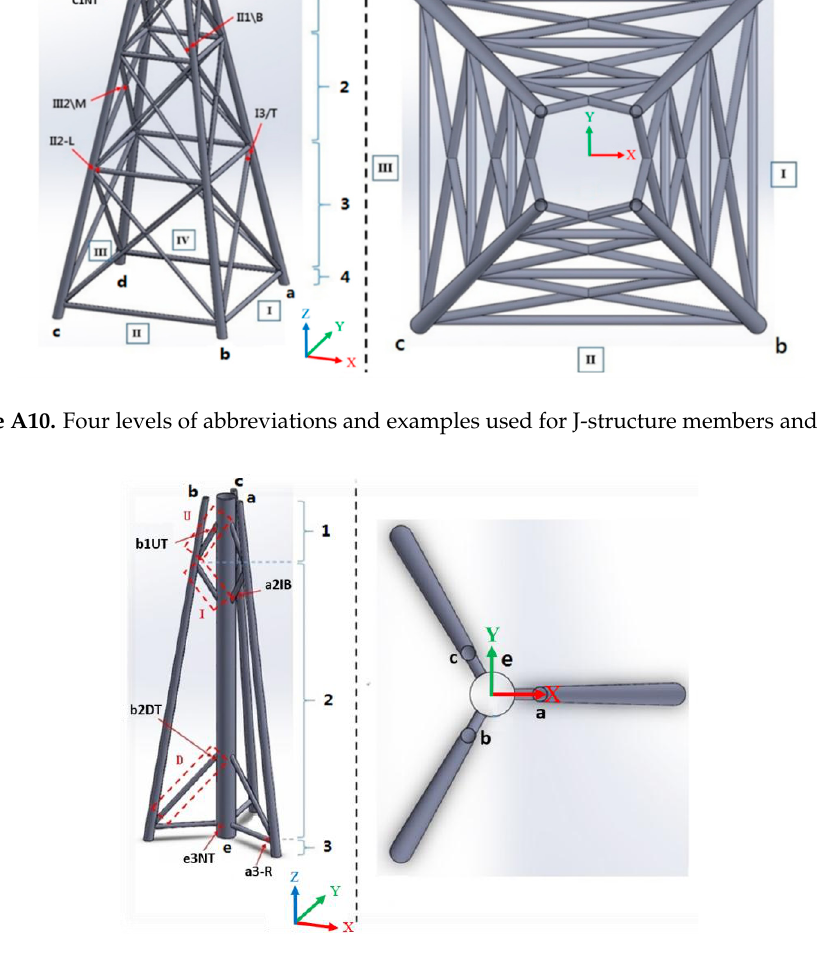
Figure A11. Four levels of abbreviations and examples used for TJ-structure members and parts.